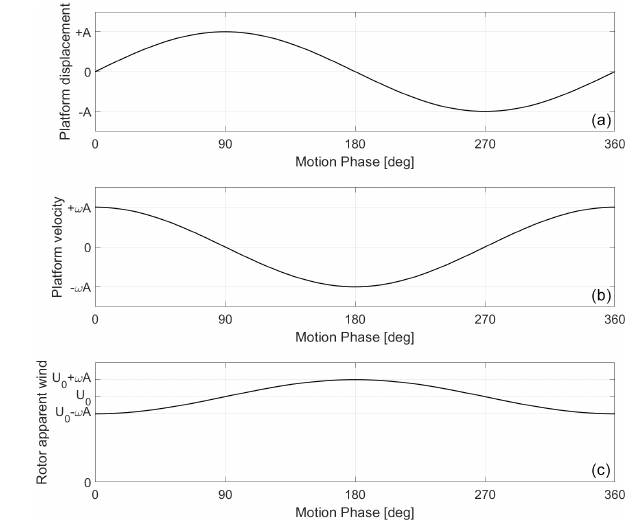
Figure 11. Platform displacement (a) , platform velocity (b) , and rotor apparent wind (c) during one platform period.